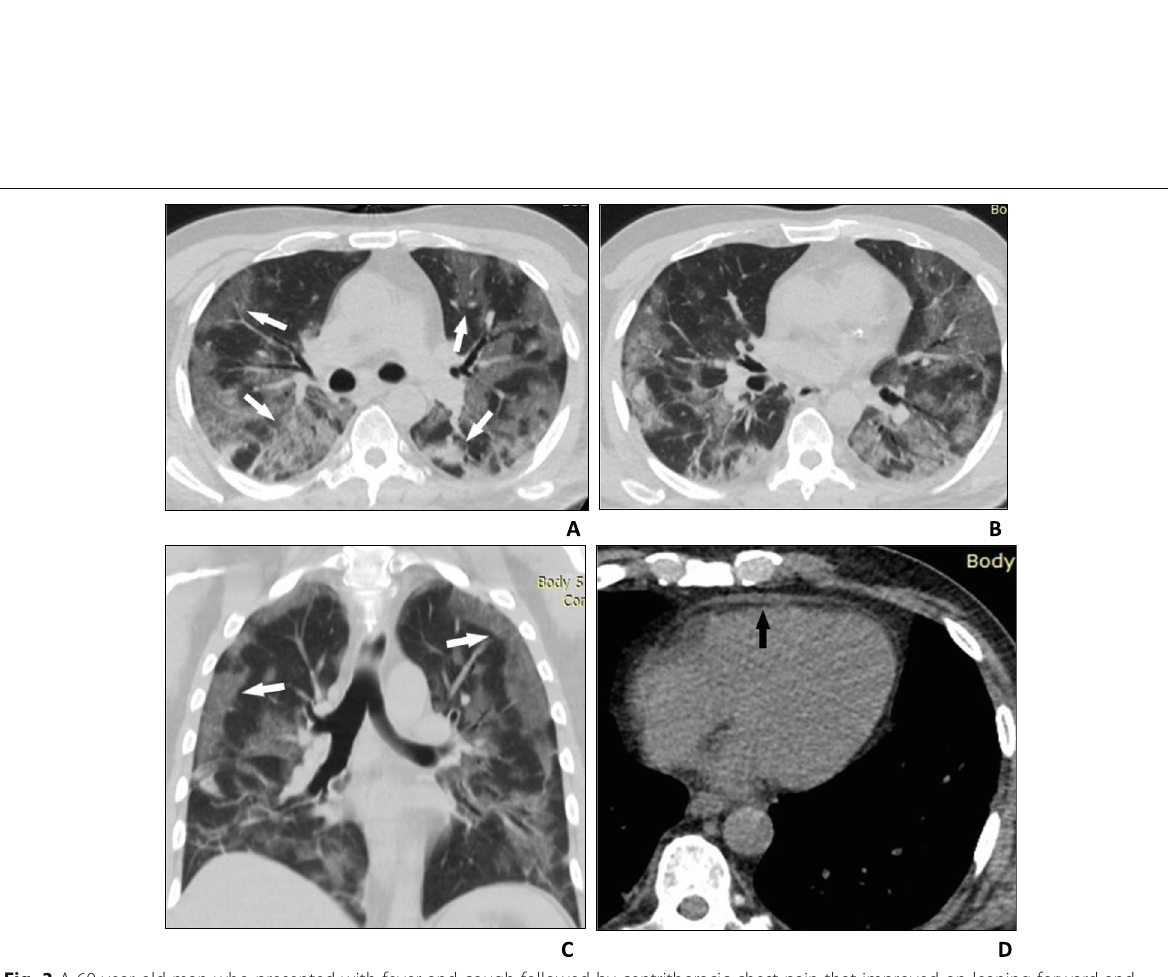
Fig. 3 A 60-year-old man who presented with fever and cough followed by centrithoracic chest pain that improved on leaning forward and increased when lying supine and progressive dyspnea requiring admission to the intensive care unit. His PaO 2 /FiO 2 ratio was 220 mmHg. a – c Axial and coronal thin-section unenhanced CT scan shows diffuse bilateral confluent and patchy ground-glass and consolidative (white arrows) pulmonary opacities with peripheral and central distribution. d Axial image shows thickened pericardium > 2 mm (black arrow) suggesting pericarditis confirmed by